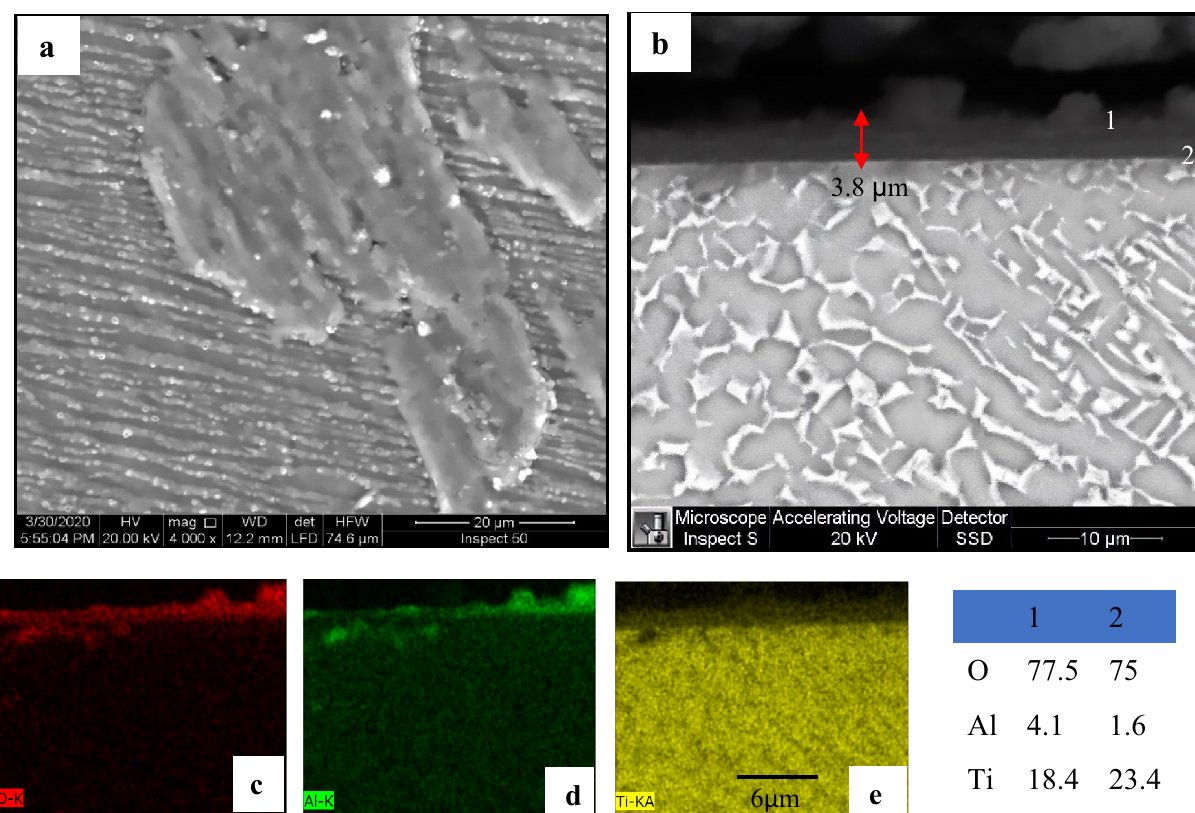
Figure 6. SEM and EDS analysis for oxide specimens at 700 °C after 50 h exposure presents ( a) morphology, ( b ) cross-section, and ( c, d, e ) element map